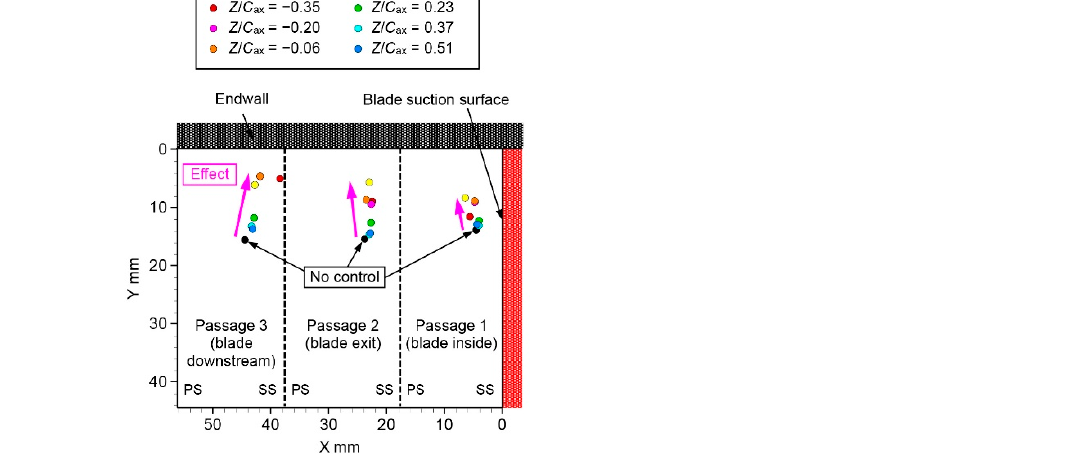
Figure 10. Center positions of passage vortex at various plasma actuator locations (Re out = 1.8 × 10 4 ).